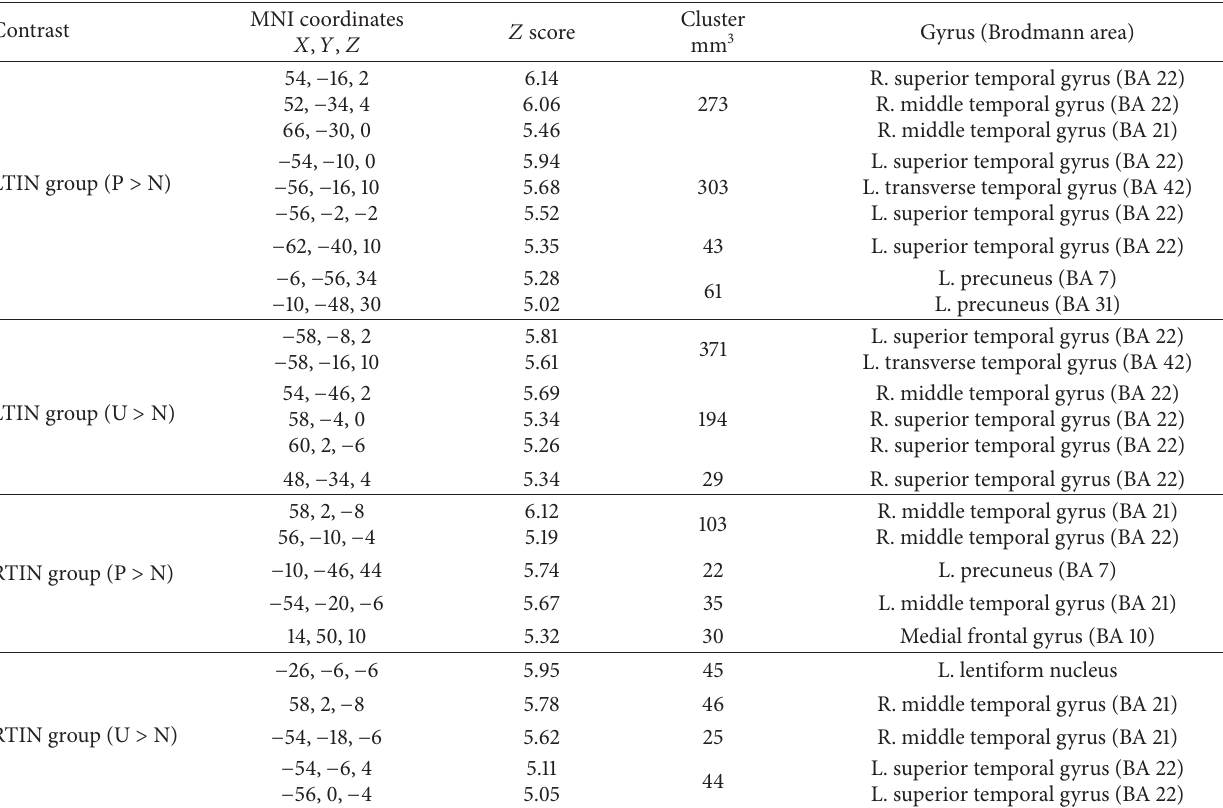
Table 4: Local maxima for the whole-brain analysis for within-group contrasts in the emotion task experiment. Whole-brain analysis for both P > N and U > N conditions was computed for each group. Regions are listed in Montreal Neurological Institute (MNI) coordinates. Brodmann areas are also provided (before determining the Brodmann areas, the MNI coordinates were converted to Talairach coordinates). Statistical threshold was set at 𝑝 < 0.025 FWE corrected for multiple comparisons. L: left; R: right; P: pleasant; N: neutral; U: unpleasant.